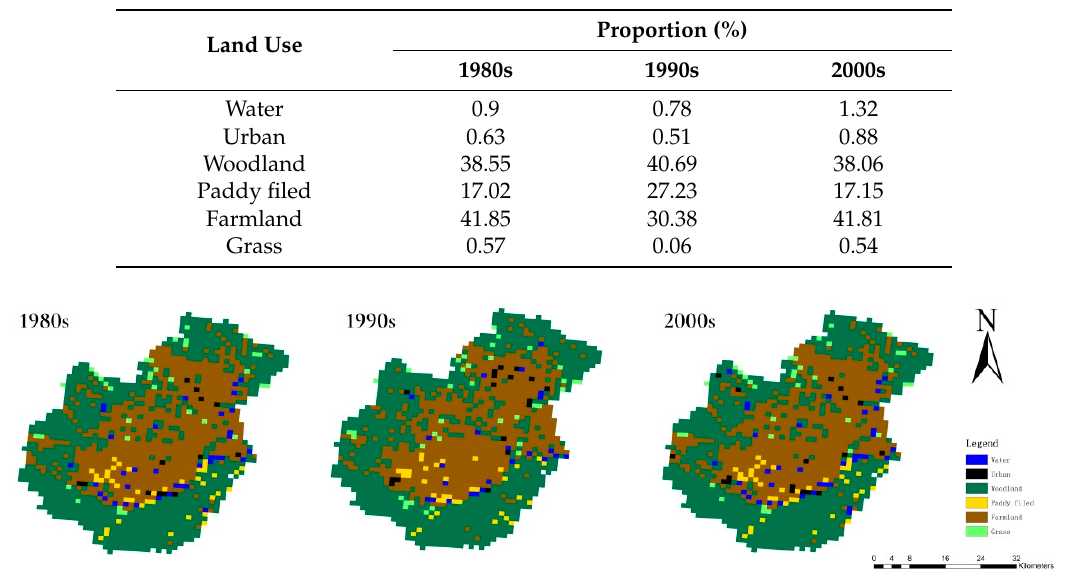
Table 2. The land use data for three periods in the basin.